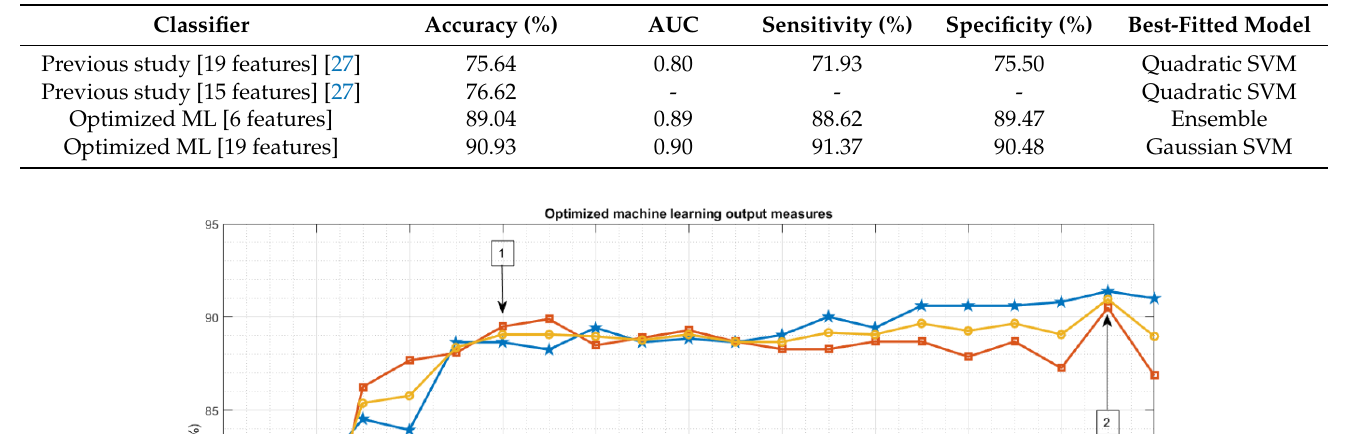
Table 3. Classification outputs using ranked microstate features obtained from the EEG dataset for patients diagnosed with SZ and healthy control subjects.